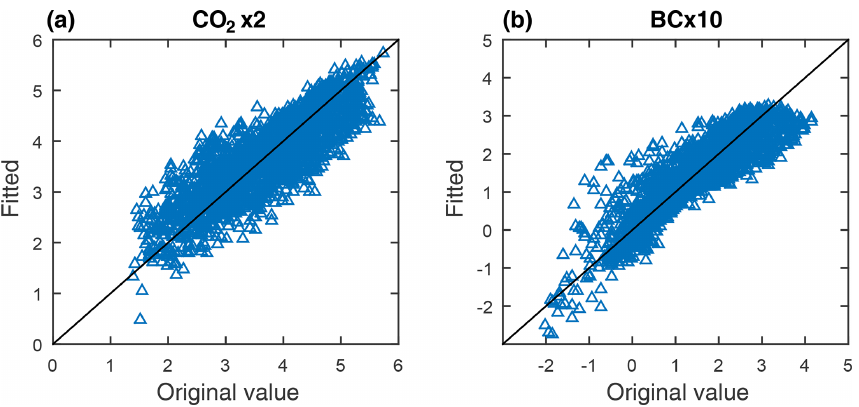
Figure 10. Comparison of fitted T max from the linear models vs. original T max values. Blue triangles are values for all grid boxes over the NH, and the black solid line represents the one-to-one line. Table 2. Domain-averaged T max changes from each radiative component estimated from the linear models